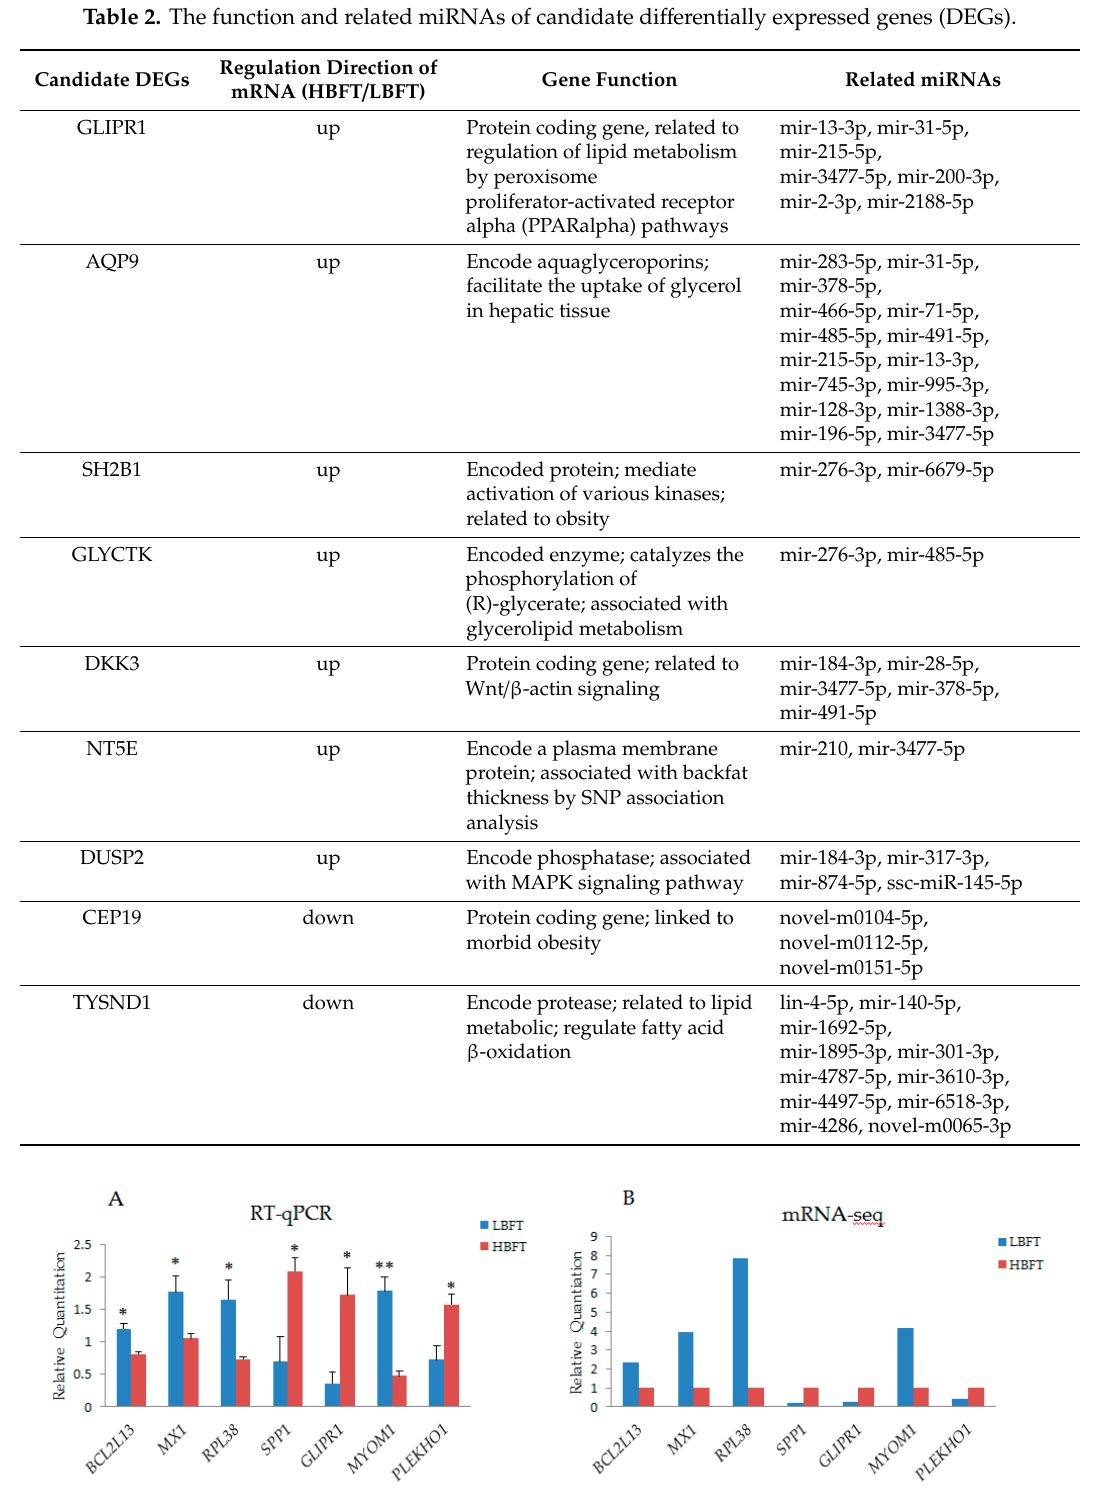
Figure 4. Validation of mRNA-seq data using RT-qPCR ( A ), RT-qPCR results of seven selected miRNAs ( B ), and mRNA-seq results of seven genes (Y-axis represents that the fragments per kilobase of transcript per million (FPKM) of each gene in LBFT, and HBFT groups were normalized by FPKM of LBFT).